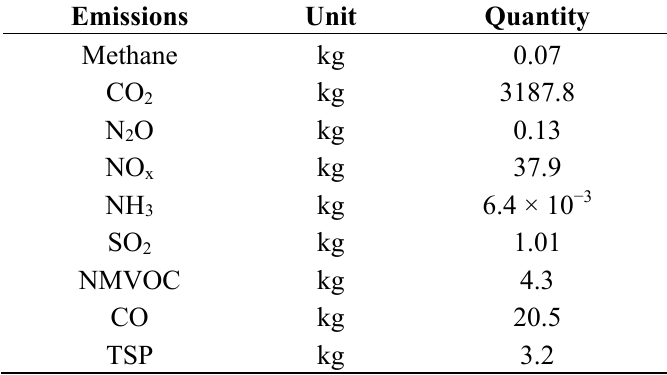
Table A4. Diesel emissions per ton of diesel combusted (elaborated from [82]). Emissions